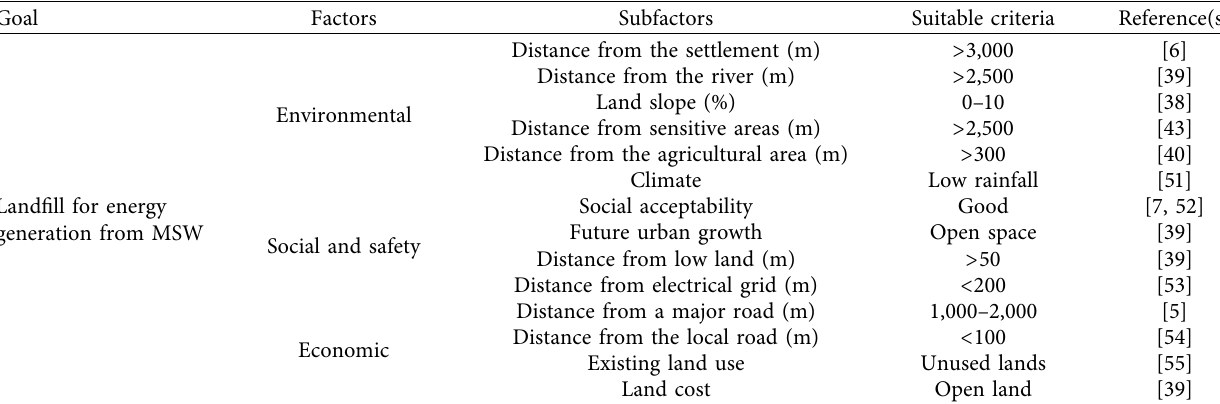
Table 9: The suitable criteria of landfill for energy